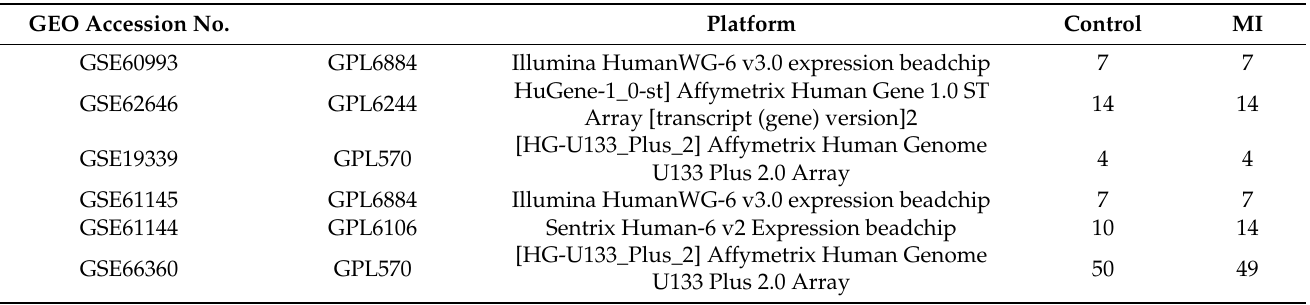
Table 3. Characteristics of the microarray datasets of myocardial infarction and healthy cohorts. GEO Accession